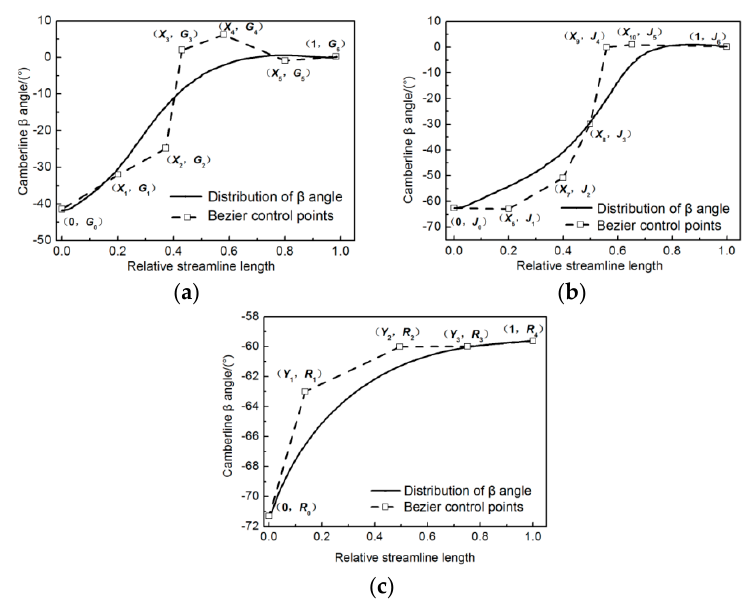
Figure 3. Schematic for the centrifugal compressor blade camber law and corresponding control parameters: ( a ) impeller hub; ( b ) impeller shroud; ( c ) radial diffuser.